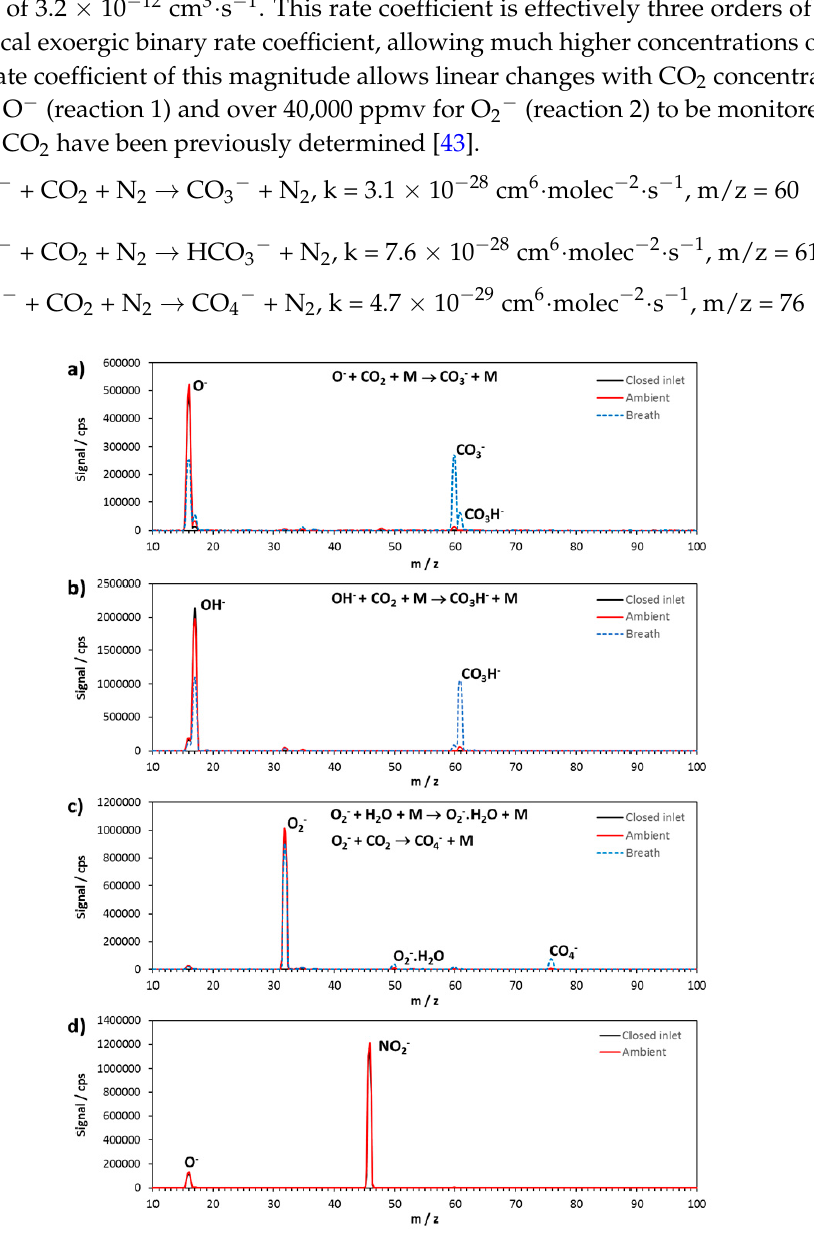
Figure 2. The downstream mass spectrometer traces for the reagent ions ( a ) O − ; ( b ) OH − ; ( c ) O 2 − ; and ( d ) NO 2 − are shown under three configurations: with a closed sample inlet, only nitrogen is in the flow tube; the trace observed when an air sample is added is marked Ambient; and the trace of a human breath exhalation is marked Breath.